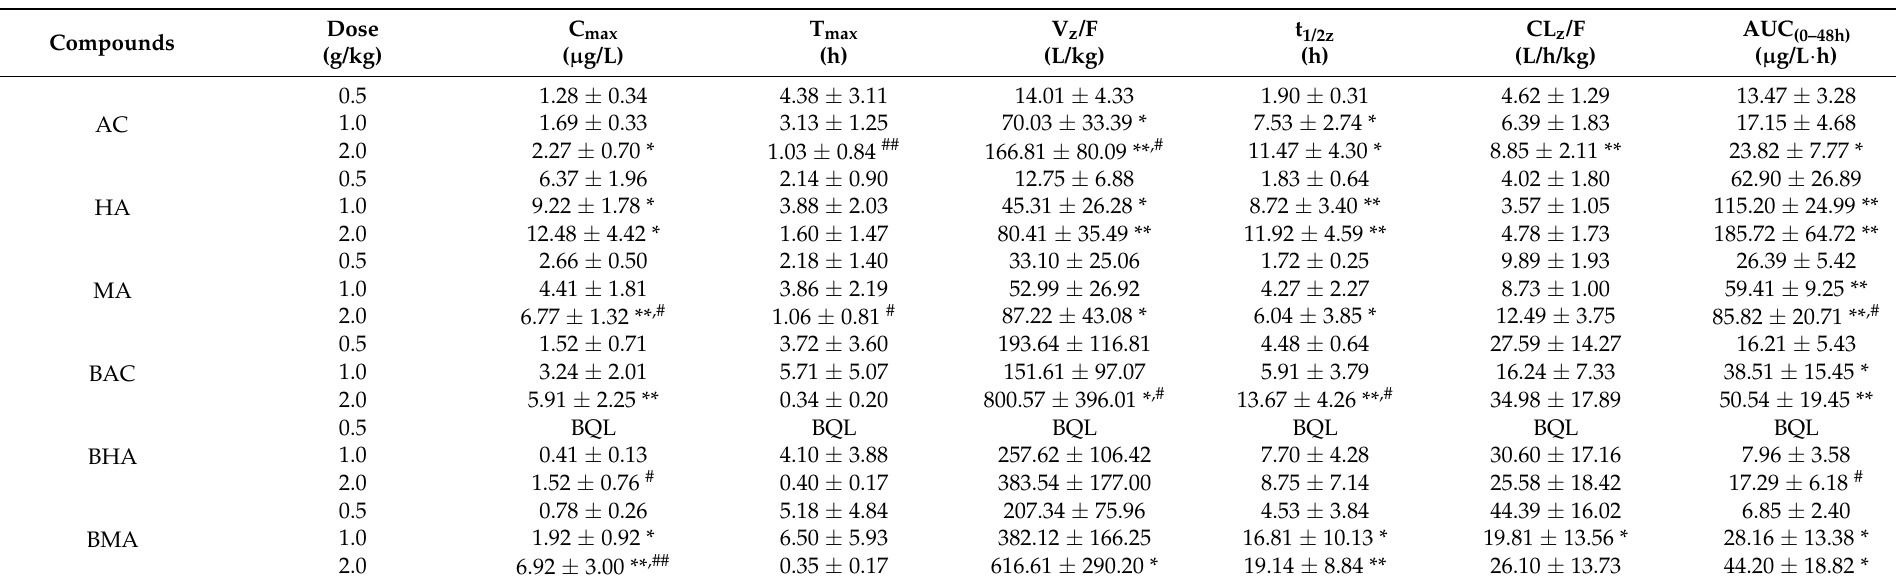
Table 5. The main pharmacokinetic parameters of the six compounds in SD rat plasma at different oral doses of 0.5 g/kg, 1.0 g/kg and 2.0 g/kg of Fu Zi extracts (mean ± SD, n =